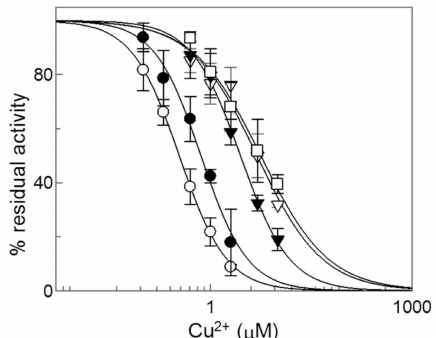
Figure 6. Dose-response analysis of copper e ff ect on Cys mutants of CAC. ( C89S / C283S, ( (cid:53) ) C136S, ( (cid:72) ) C155S and ( (cid:3) ) C136S / C155S. After 1 min of incubation with Cu 2 + at the indicated concentrations, transport activity was measured by adding 0.1 mM [ 3 H]-carnitine and stopped after 30 min as described in Materials and Methods. Percent of residual activity with respect to the control, without Cu 2 + treatment, was reported. The values were the means ± SD from three